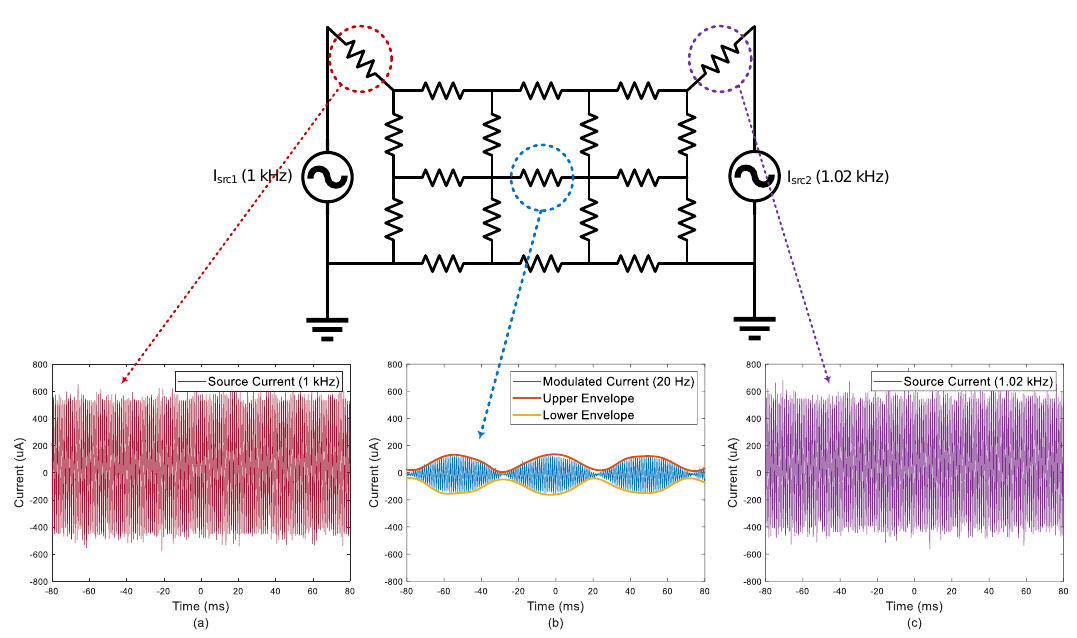
Figure 9. ( a ) Modulated current is 20 Hz and ( b ) 1 kHz sine current source and ( c ) 1.02 kHz sine current